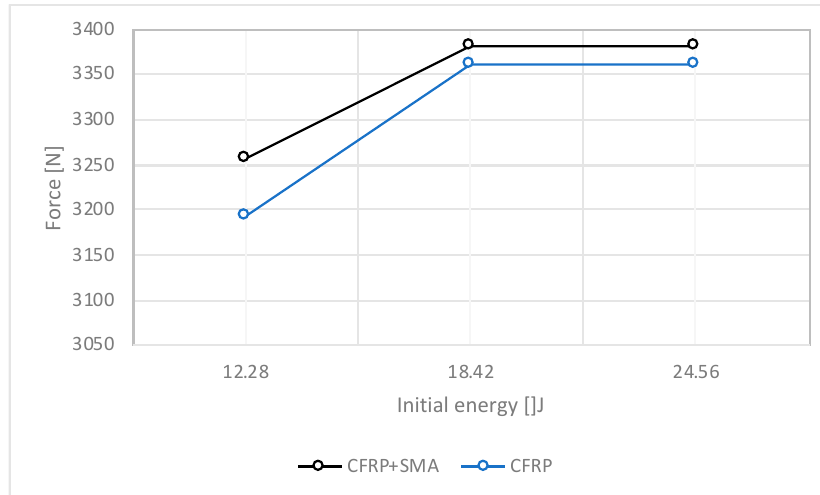
Figure 7. Comparison of the maximum force between PPS/carbon fibre (CF) and hybrid composite.